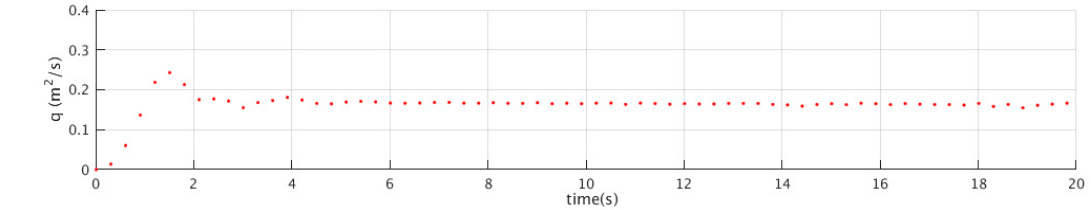
Figure 7. Discharge hydrograph upstream of weir entrance.